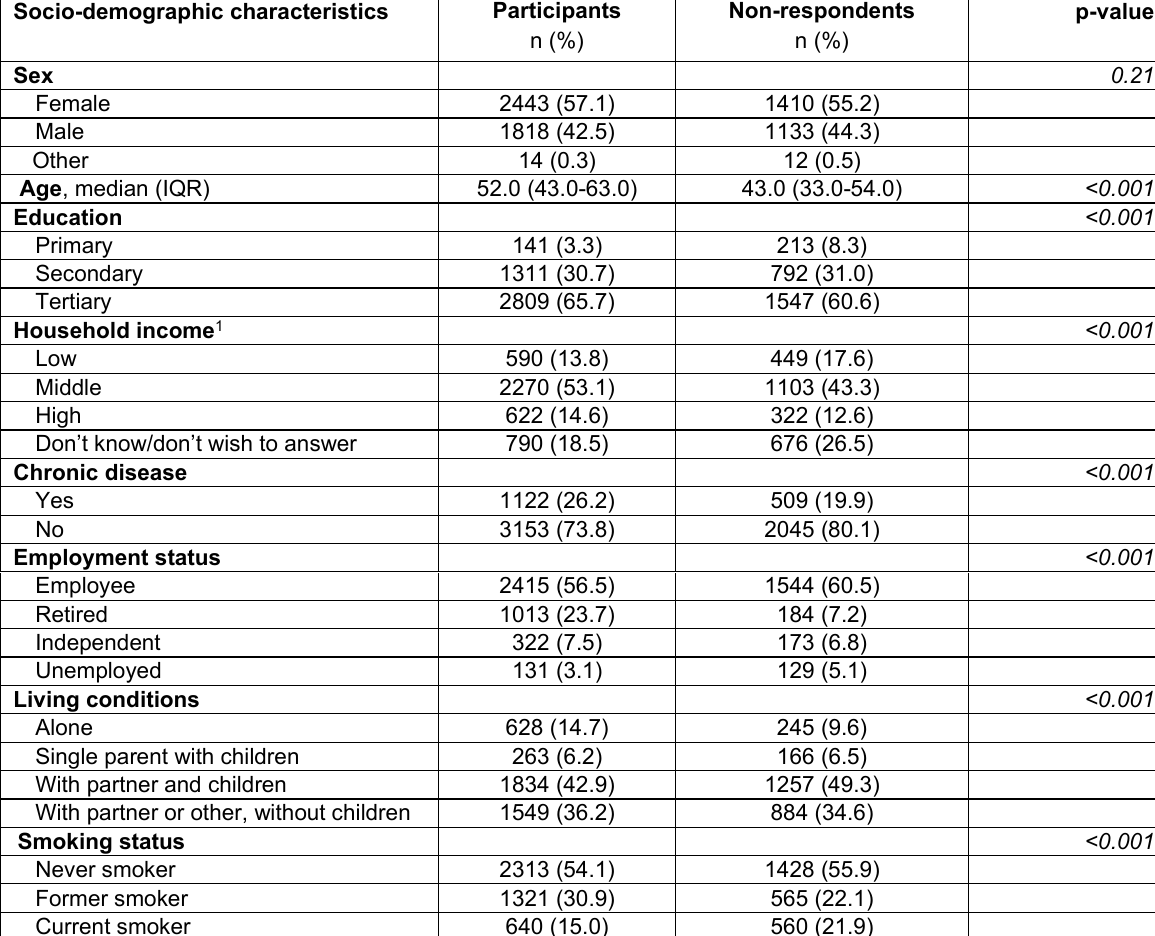
Supplementary table 4 . Characteristics of overall sample participants and of non-respondents Socio-demographic